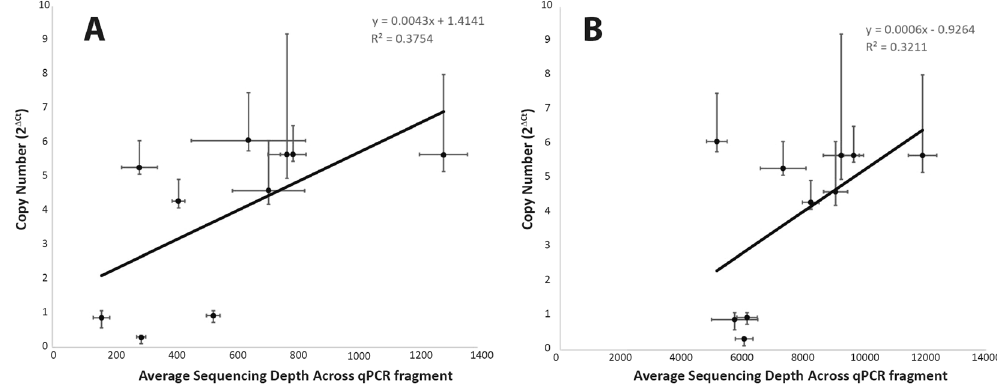
Figure 4. Correlation Between Previous qPCR Results and Sequencing Depth of the Capture Data. For ten genes, the average sequencing depth across a fragment amplified by qPCR is compared to the previously measured 17 copy number, measured by the Δ Ct of the qPCR reaction relative to the average Ct value of six single copy B. malayi genes, for the depletion data 17 (Panel A,) and the capture data (Panel B). The error bars for the copy number are derived from one standard deviation of the Δ Ct, making them asymmetric since copy number is exponentially related to Δ Ct. The error bars for the average sequencing depth are one standard deviation. A comparison of the plots for the capture data presented here and the previously presented depletion data reveals similar R 2 values but different y-intercepts and slopes. A lower y-intercept is expected for the capture data relative to the depletion data since it will be altered by the presence of the sequencing reads from the endosymbiont genome. A different slope is expected due to the differences in the sequencing